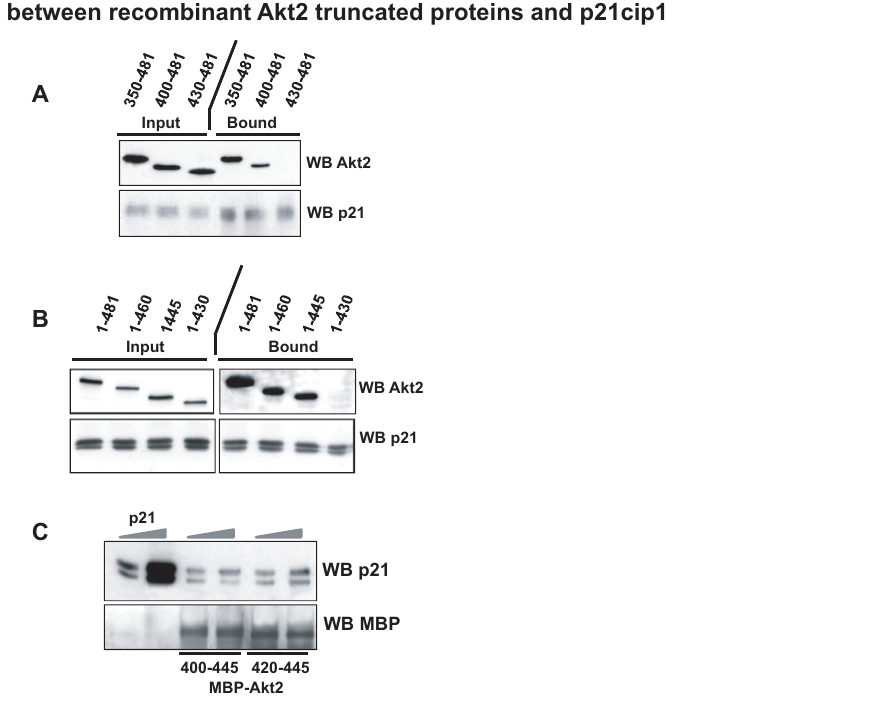
Figure 1. In vitro binding between recombinant human Akt2 truncated proteins and human p21cip1. A. Pull-down assay was performed between each of three recombinant N-terminal truncated Akt2 proteins (350–481, 400–481, 430–481) and recombinant human p21cip1. Inputs are shown on the left and pull down assays on the right. Membranes were blotted with Akt2 and with p21 as a control. B. Immunoprecipitations ( in vitro ) were performed between each of four recombinant full length Akt2 (1–481), C-terminal truncated Akt2 proteins (1–460, 1–445 and 1–430) and human recombinant p21cip1. Inputs are shown on the left and pull-down assays on the right. Membranes were blotted with Akt2 and with p21 as a control. C. Pull-down assay was performed between Akt2 peptides (400–445) or (420–445) and recombinant p21cip1. Increasing inputs of p21 (1 m g and 5 m g) are shown on the left lanes and pull-down assays with increasing amounts of p21 on the right lanes. Membranes were blotted with p21 and with MBP as a